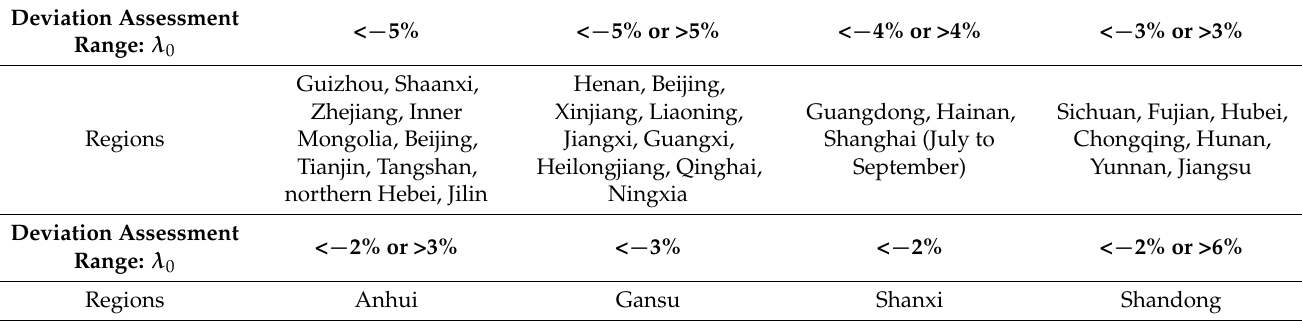
Table 1. Deviation assessment range in different